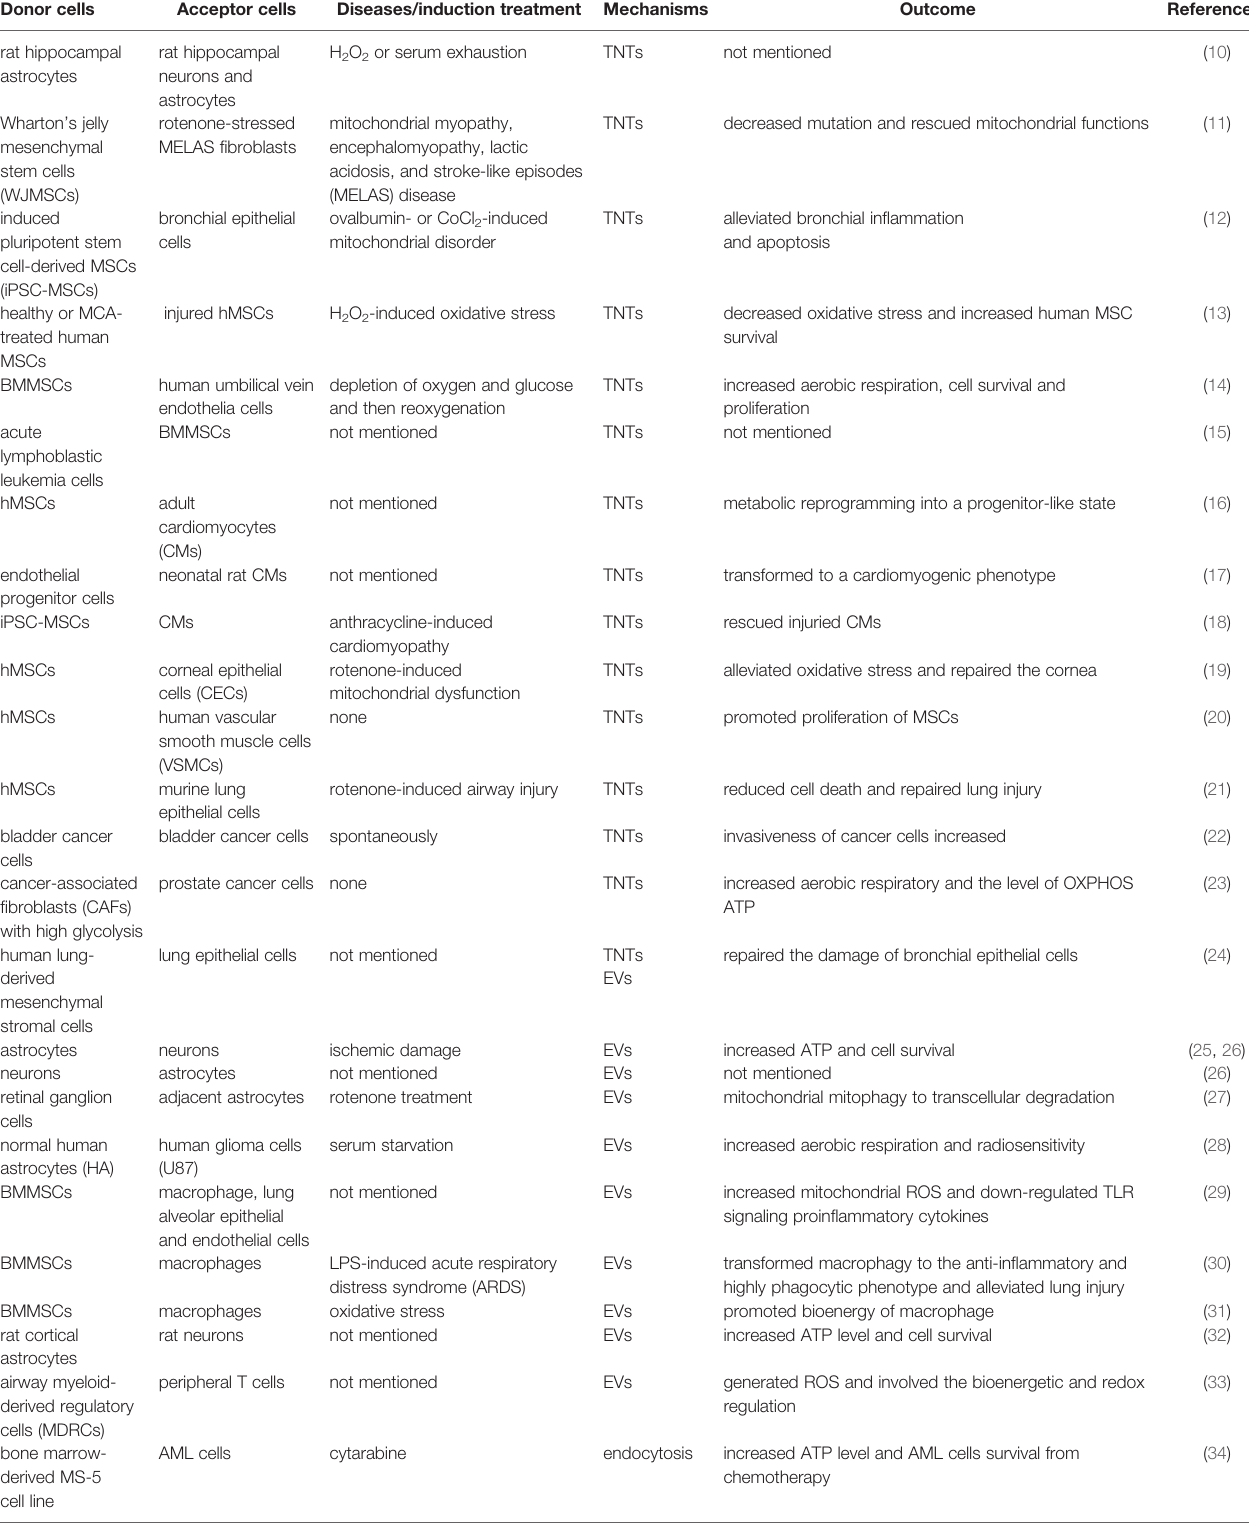
TABLE 1 | Donor and Recipient Cells involved in the Transcellular Transport of